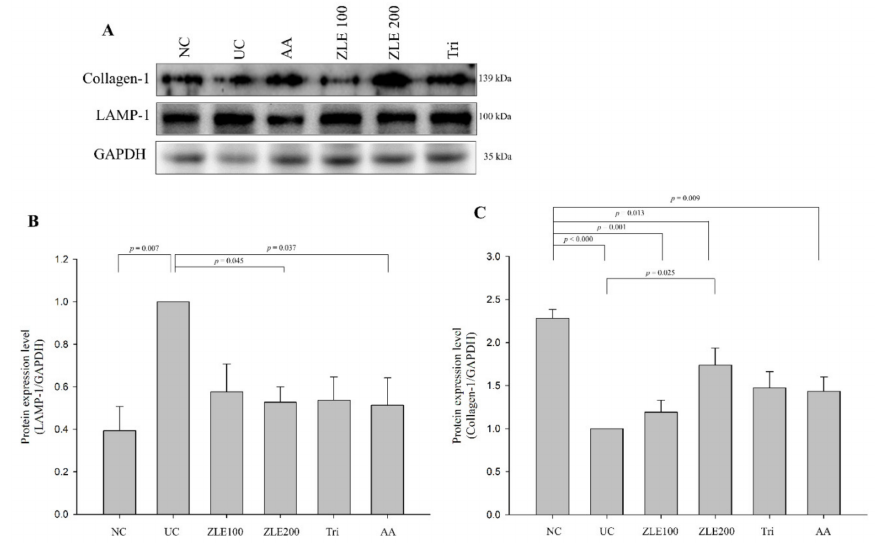
Figure 10. E ff ects of enzyme-treated Z. latifolia extract (ZLE) and tricin on the expression of LAMP-1 and collagen-1 in the UVA-irradiated skin tissue. The expression levels of LAMP-1 and collagen-1 were measured by Western blotting. GAPDH was used as an endogenous control. ( A ): Representative images of Western blot analysis. ( B ): Quantification of LAMP-1. ( C ): Quantification of collagen-1. Data are expressed as the mean ± SE. The p values are determined by ANOVA and Tukey’s HSD